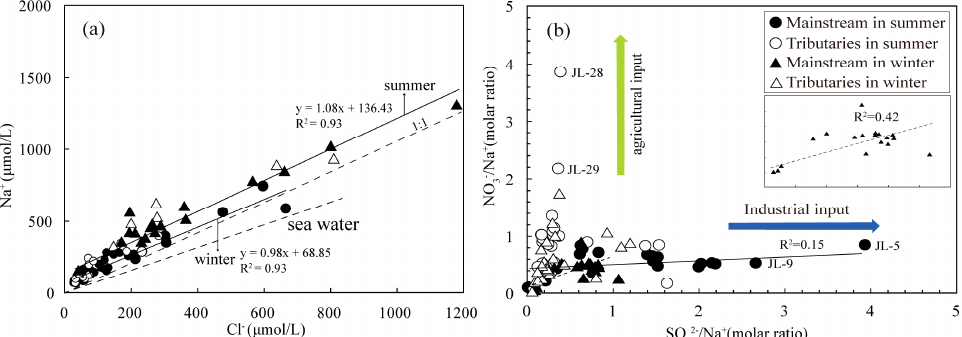
Figure 4. ( a ) Relationship between Na + and Cl − in the JR. Data of sea water (Na/Cl = 0.89) is from Hagedorn and Cartwright [43]. ( b ) Relationship between NO 3 (cid:2879) /Na + and SO 42 (cid:2879) /Na + for river waters in the JR.